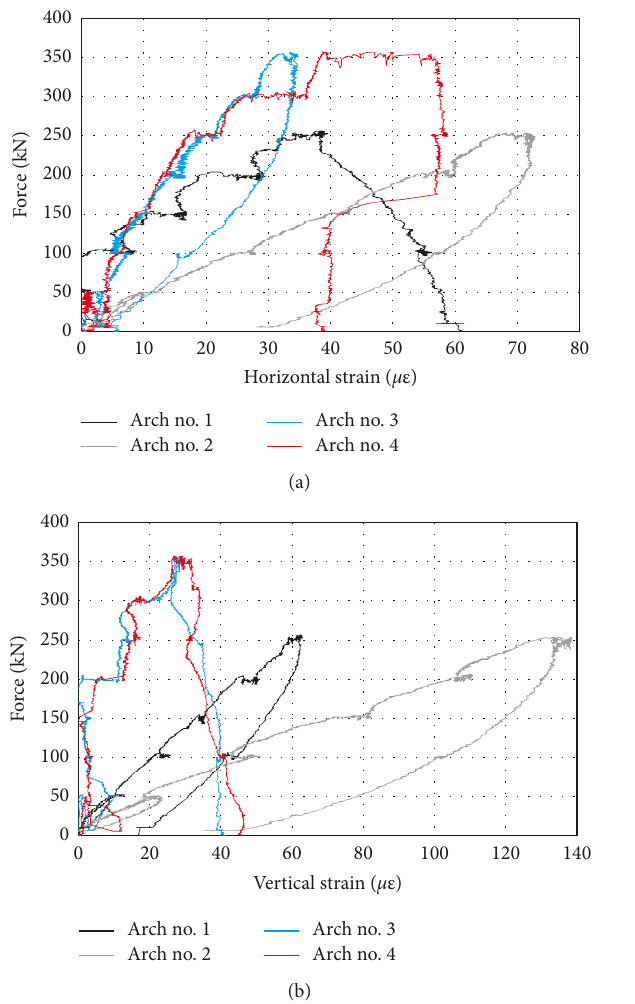
Figure 10: Test on arches subject to static symmetric loading (Figure 8(a)): (a) horizontal average strain measured at key brick; (b) vertical average strain measured at the quarters on the upper wall portion on the arch.